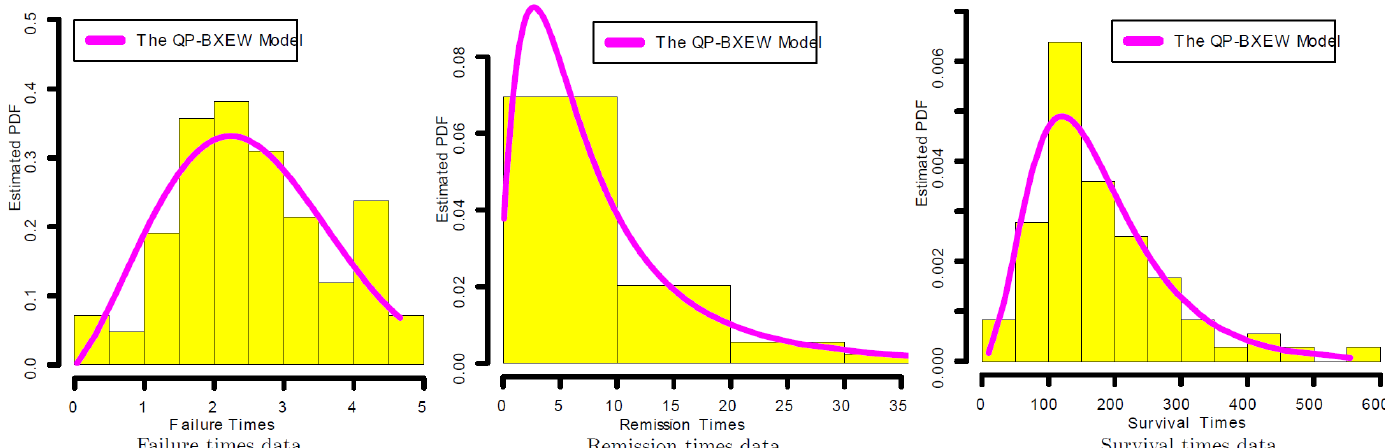
Figure 3: Estimated